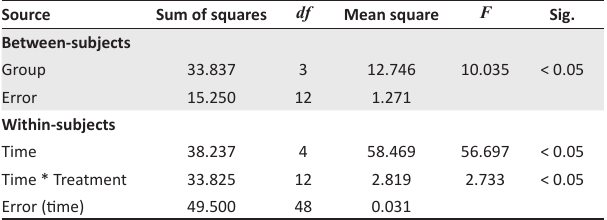
TABLE 4: Summary of 2-way analysis of variance for repeated measures showing the difference in the most efficacious psychotherapies (cognitive-behavioural therapy, social skills training and combined cognitive-behavioural therapy + social skills training) in the treatment of conduct disorder amongst in-school